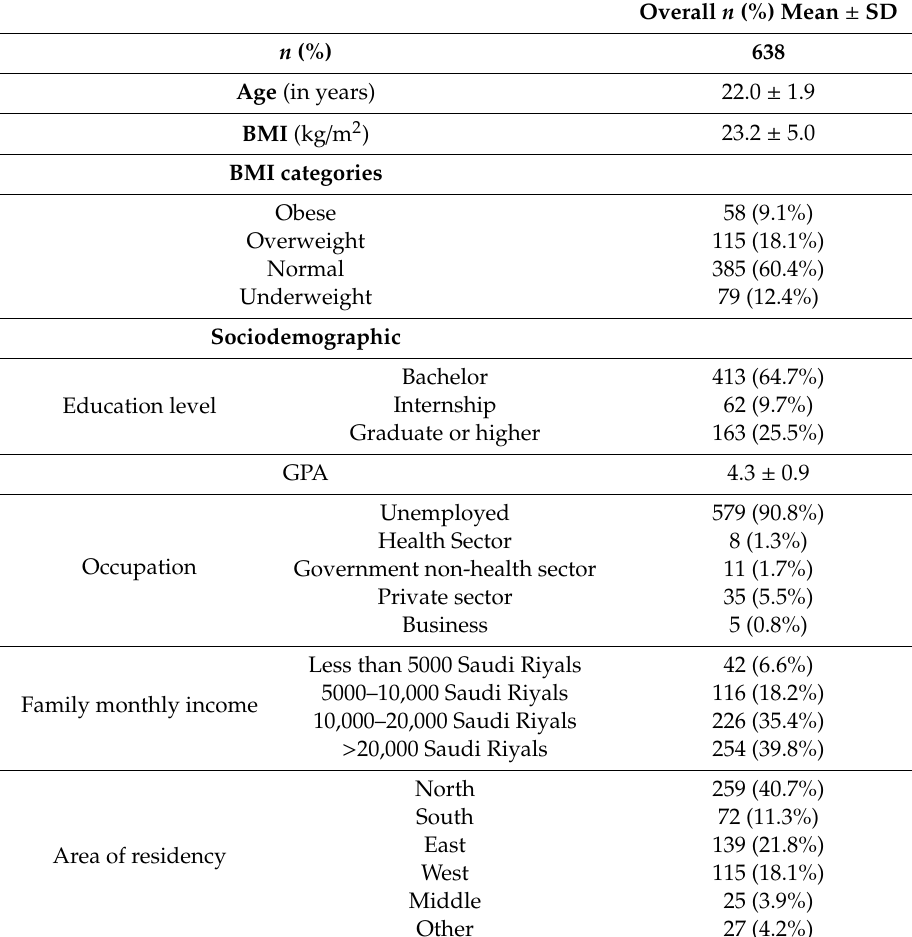
Table 1. General characteristics of study